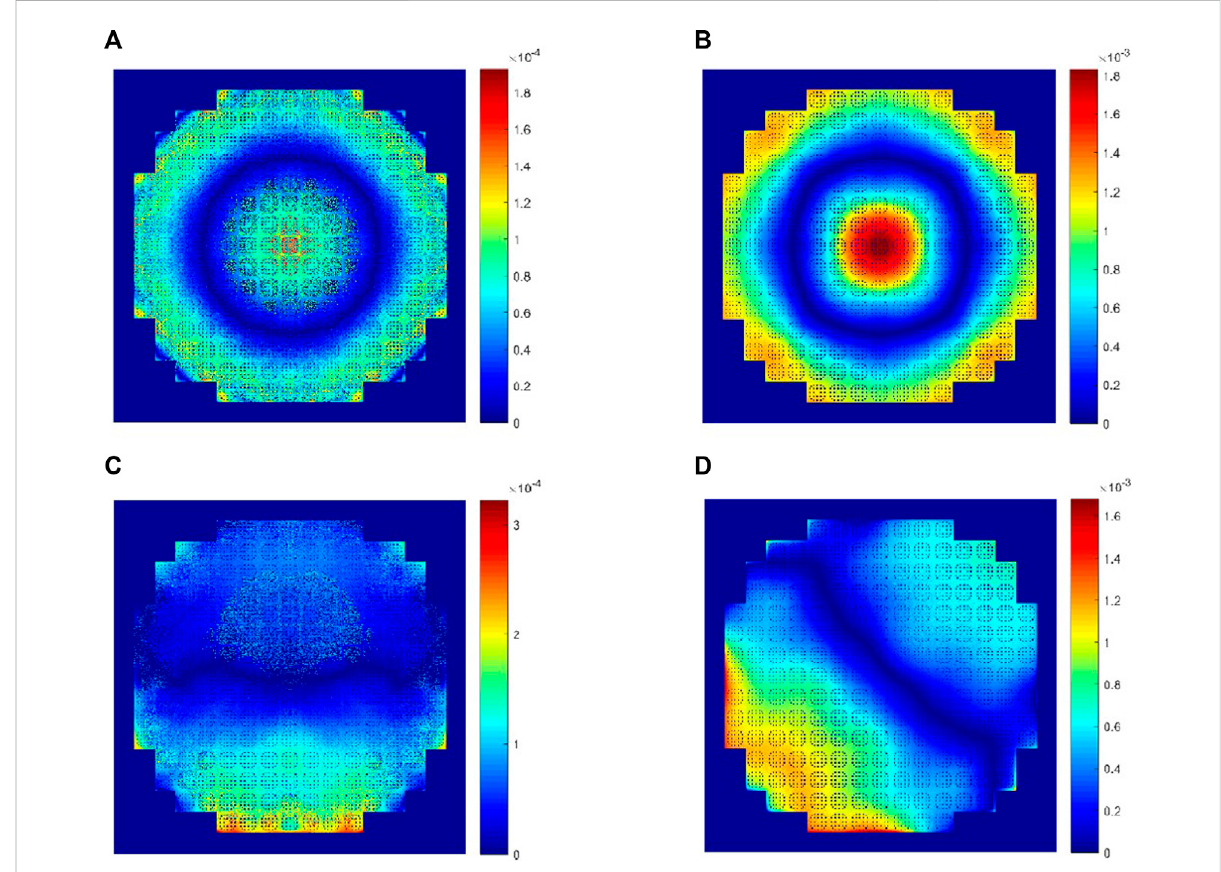
FIGURE 12 Relative errors (%) of radial average power density between comePSn_JFNK and comePSn codes for 2-D full-core MOX/UOX pin-by-pin models: (A) model A, (B) model B, (C) model C and (D) model D.